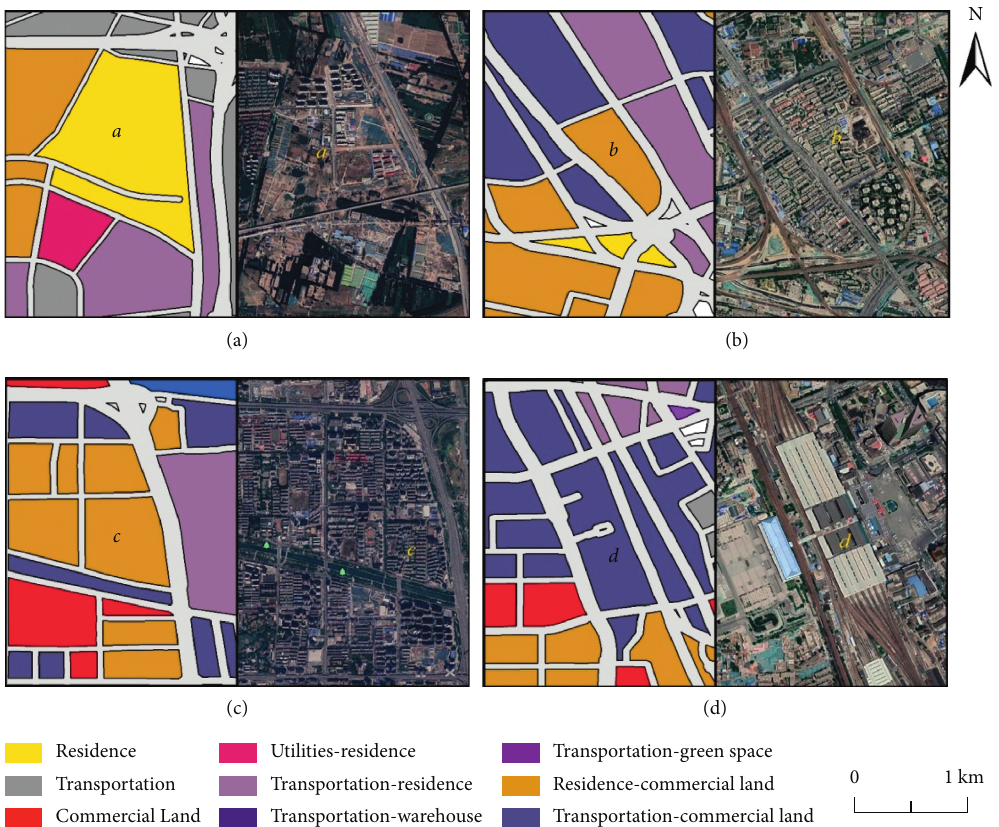
Figure 5: Result validation map. (a) The Qingshui Housing Estate. (b) The Hanfei Jinsha Housing Estate. (c) The Hensheng Community. (d) Zhengzhou Railway Station West